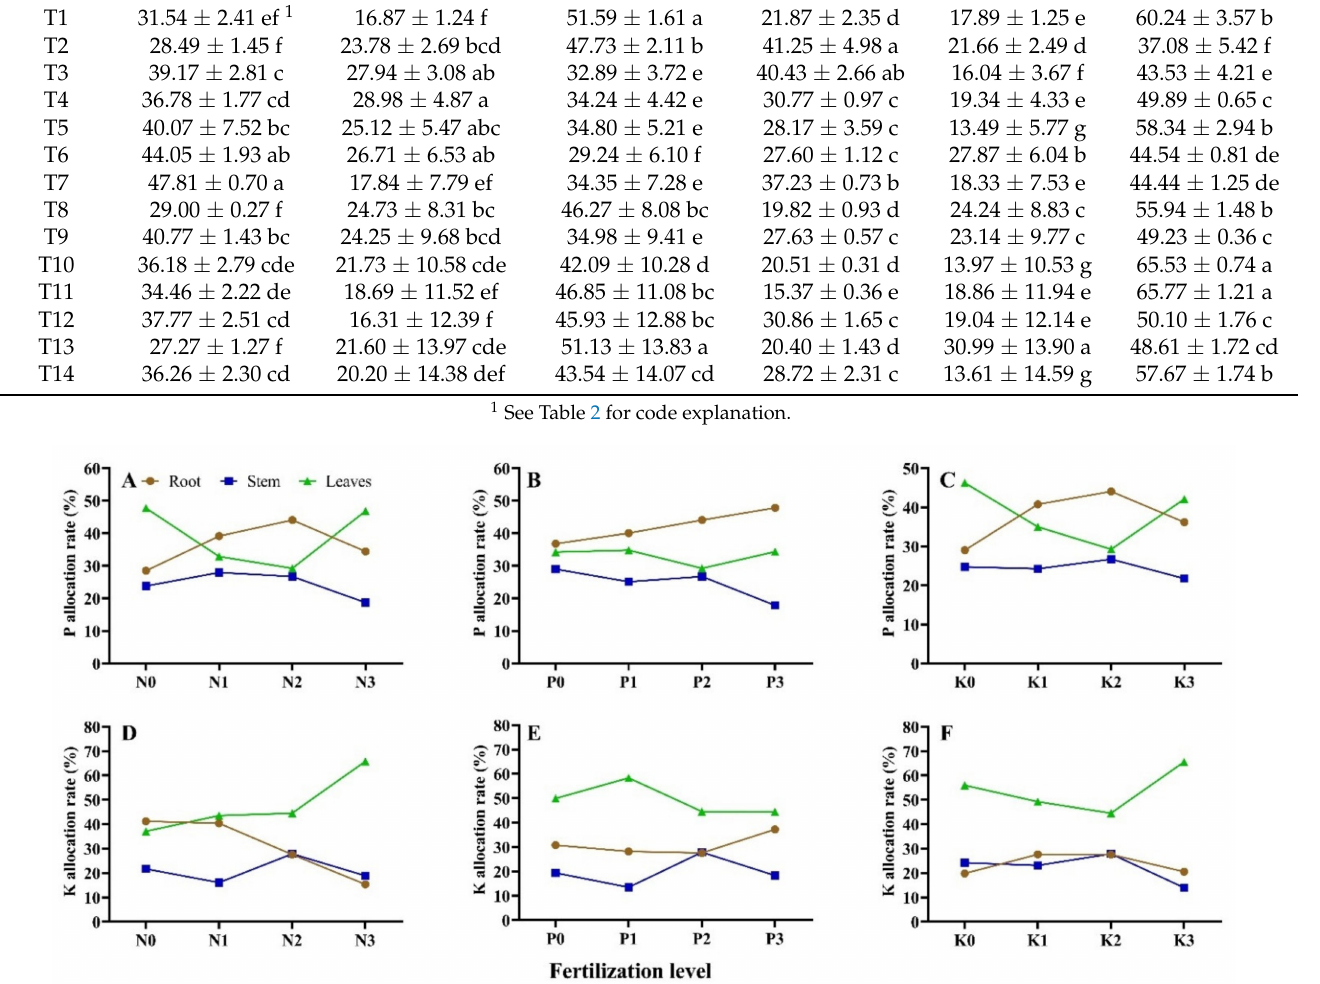
Figure 5. Changes of P and K allocation rate in P. bournei seedlings under the single-factor of N, P, and K fertilizer. ( A , D ): the single-factor of N fertilizer; ( B , E ): the single-factor of P fertilizer; ( C , F ): the single-factor of K